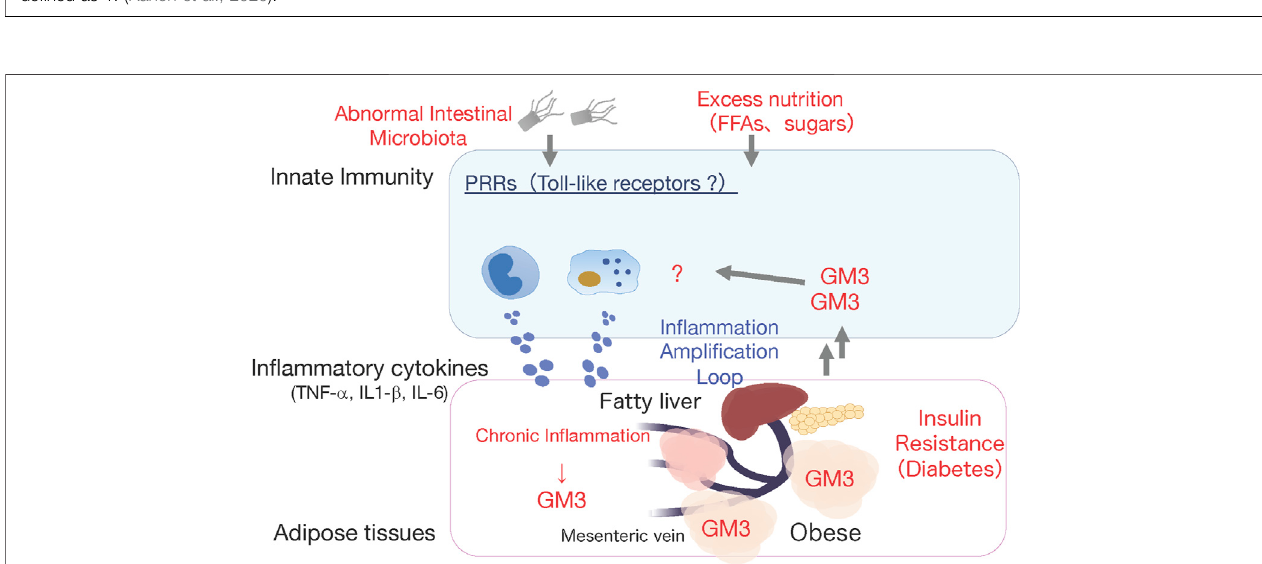
FIGURE2| Workinghypothesis:GM3isinvolvedinactivationofinnateimmuneresponses.Highfatdiet-inducedobeseGM3S-KOmiceshowedreducedobesity- induced systemic insulin resistance, and absence of chronic in fl ammation in visceral adipose tissues (Nagafuku et al.). This observation led us to hypothesize that the increased GM3 might activate innate immune responses producing in fl ammatory cytokines.